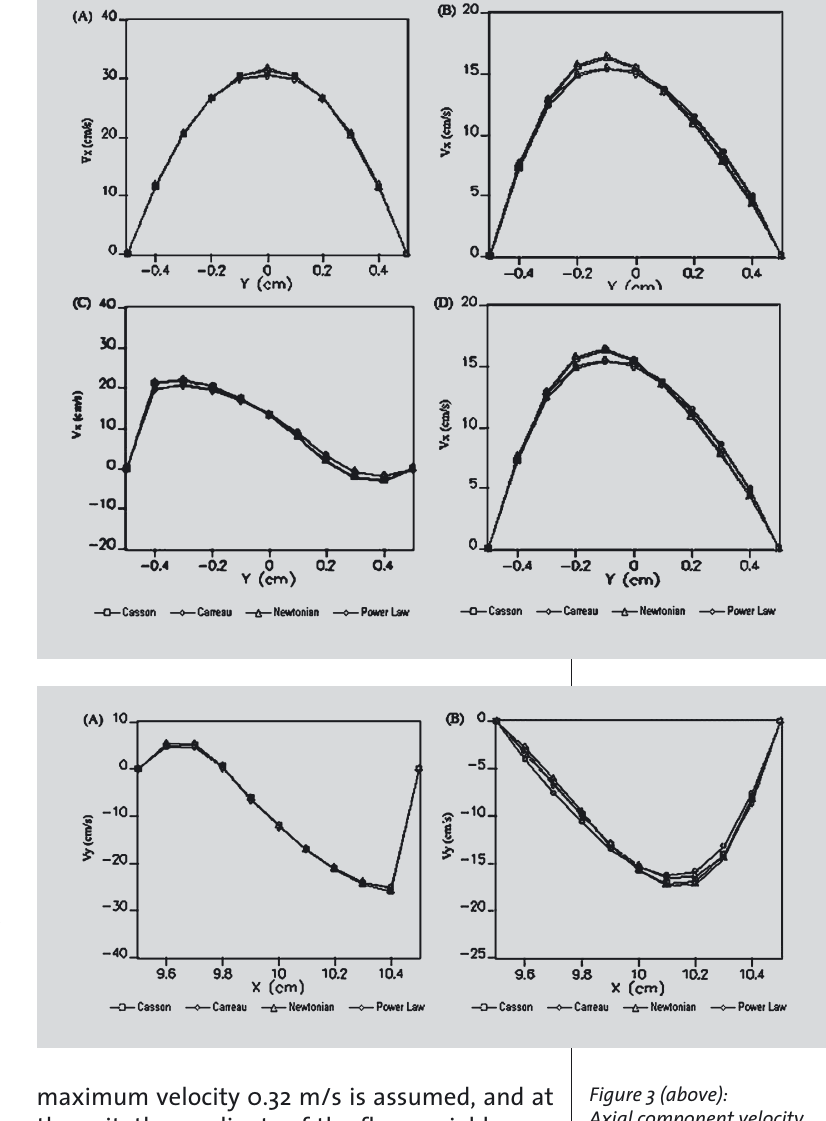
Figure 3 (above): Axial component velocity profiles in the main tube along different lines: (A) line L1, (B) line L2, (C) line L3, and (D) line L4. Figure 4: Axial component velocity profiles in the side tube along different lines: (A) line L5 and (B) line